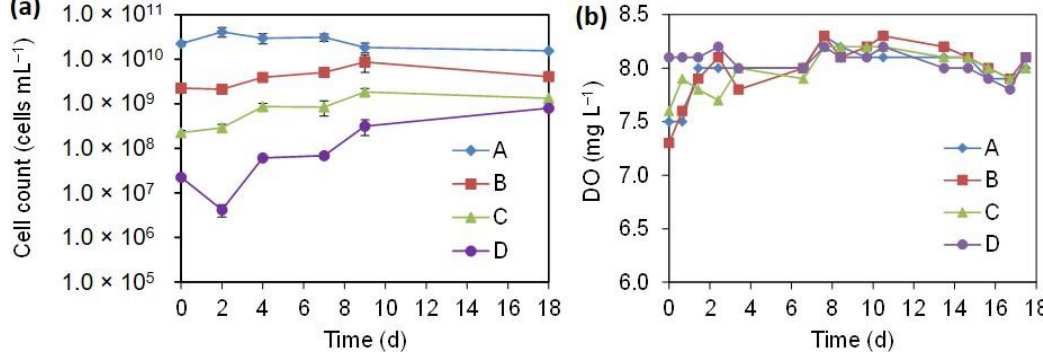
Figure 4. ( a ) Total cell counts and ( b ) dissolved oxygen (DO) concentrations in the bioreactors during the pyrite oxidation experiment.